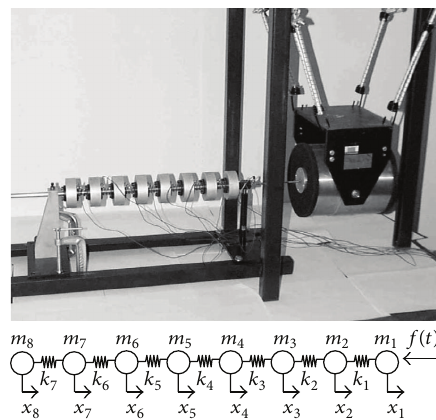
Table 2: Experimental and numerical